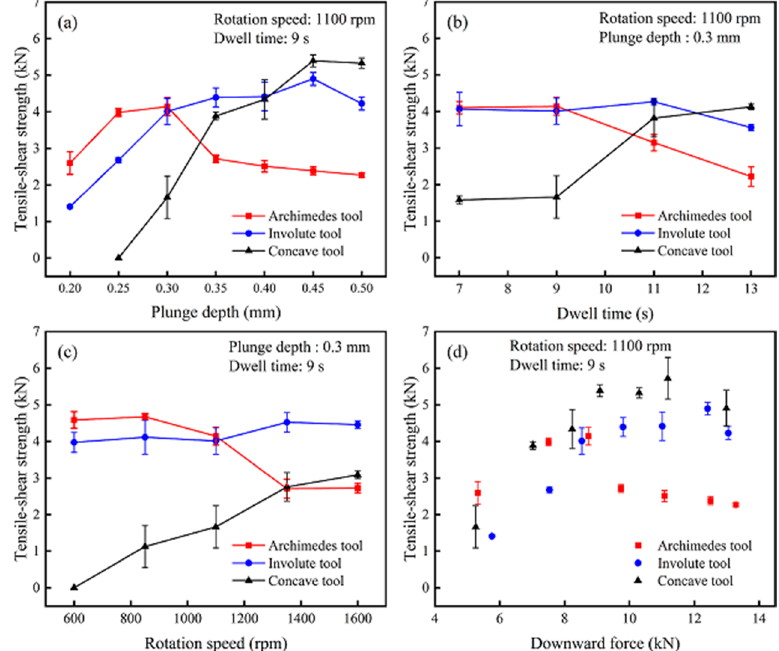
Figure 9. Evolution of tensile–shear strength with ( a ) plunge depth, ( b ) dwell time, ( c ) rotation speed, ( d ) downward force.